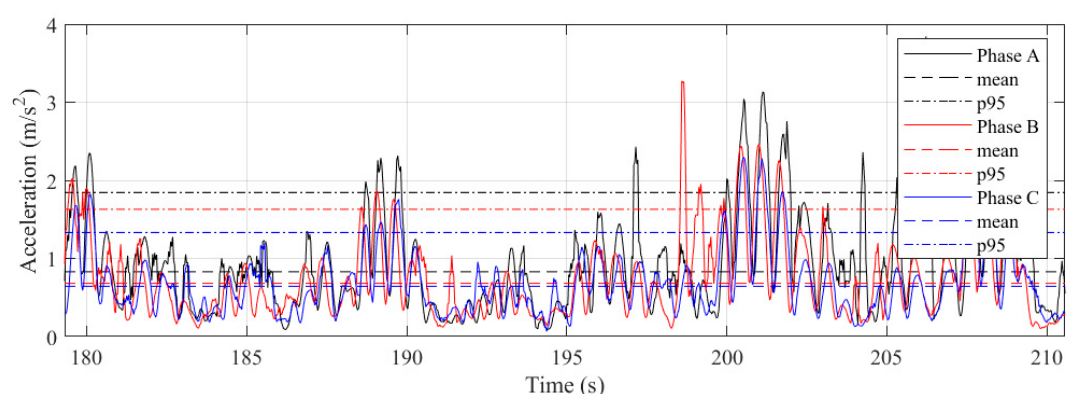
Figure 12. Comparison of acceleration time series with basic statistical measures for phases A, B and C excited by the Bret 4 wave.